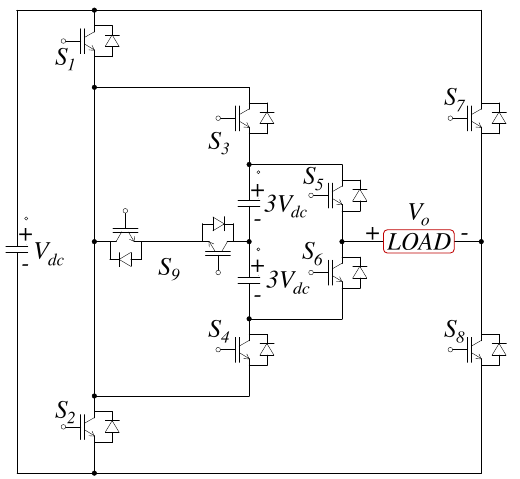
Figure 4. Multilevel topology proposed in